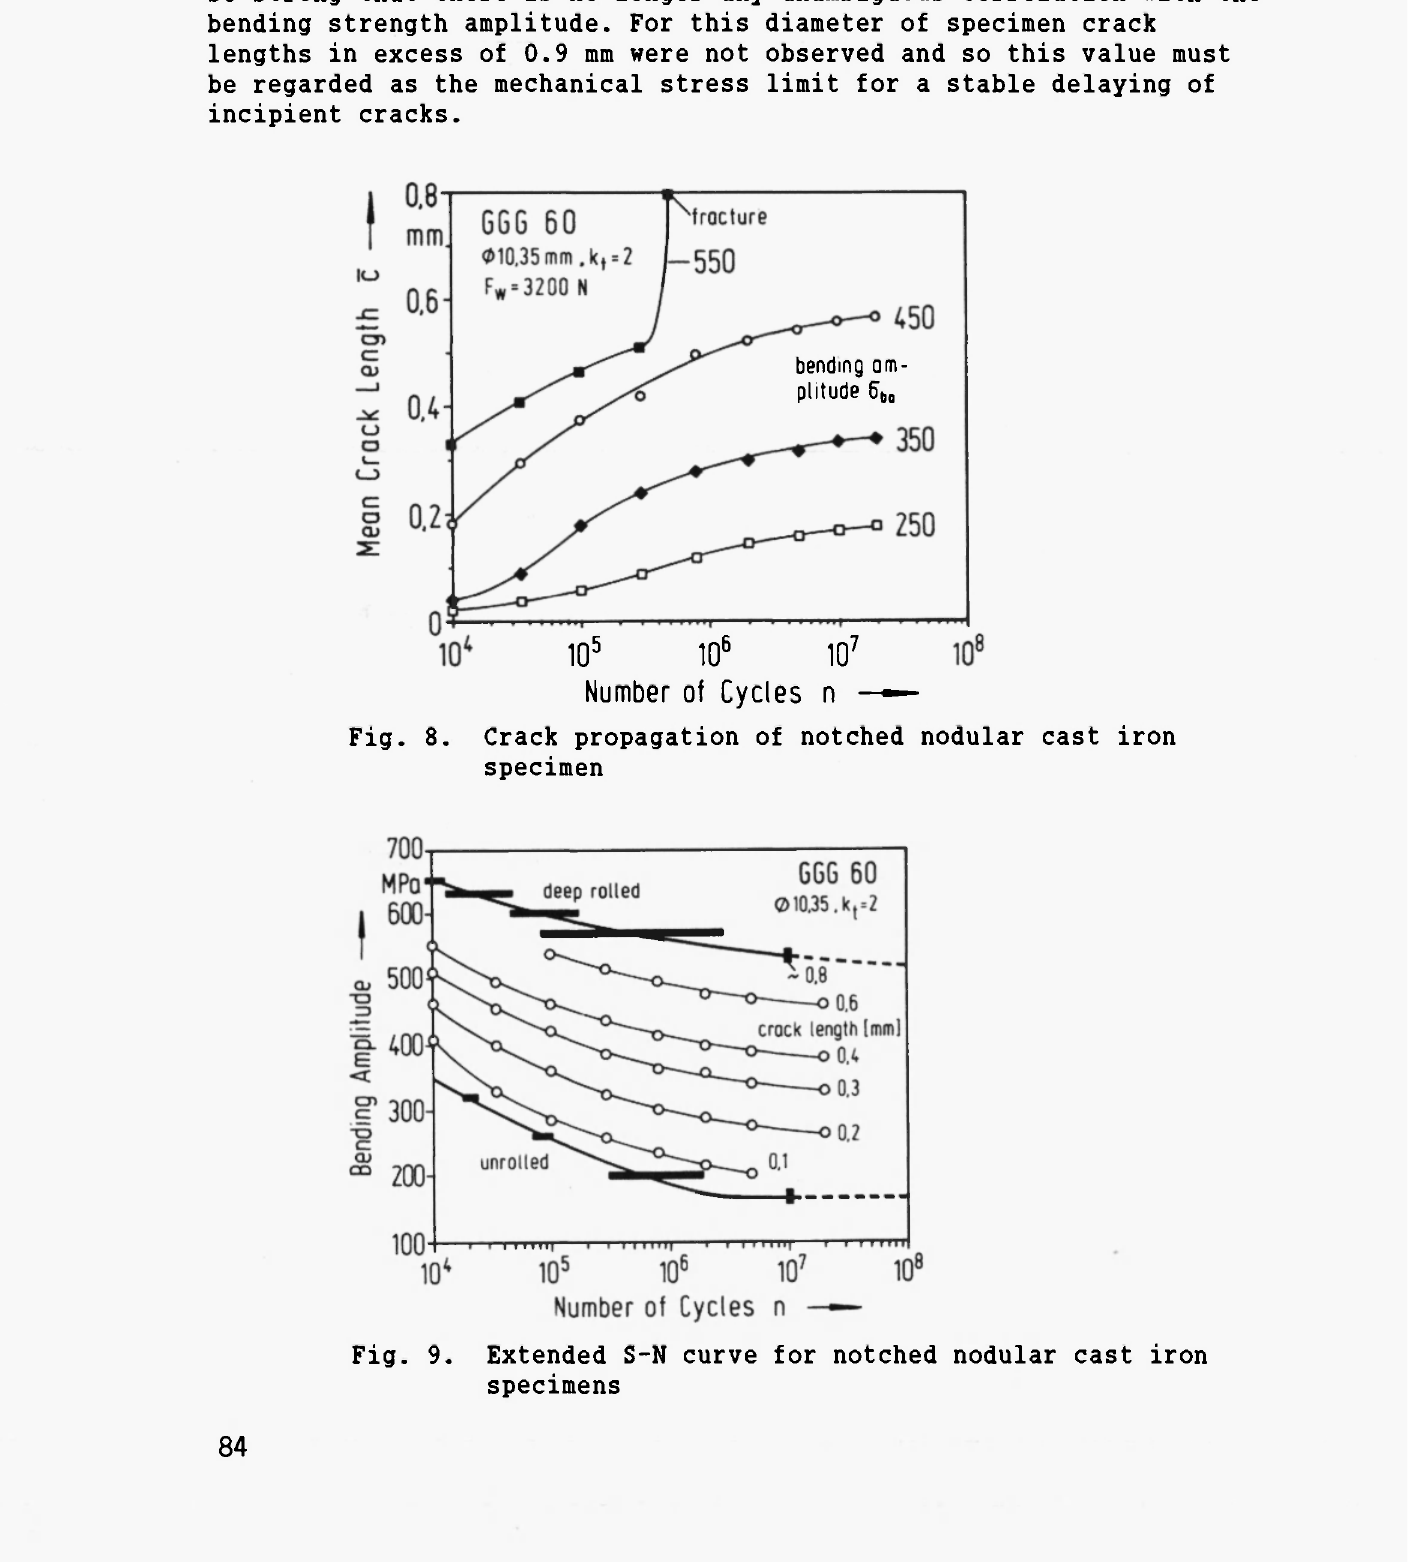
Fig. 9. Extended S-N curve for notched nodular cast iron